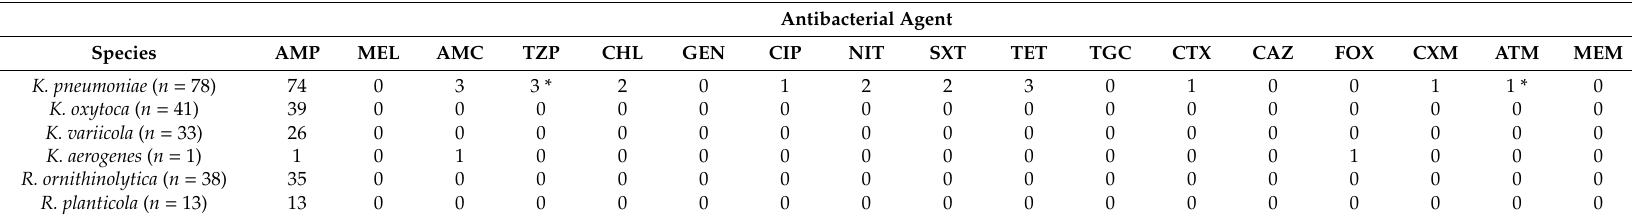
Table 2. Prevalence of antibiotic resistance among Klebsiella spp. and Raoultella spp. isolated form marine